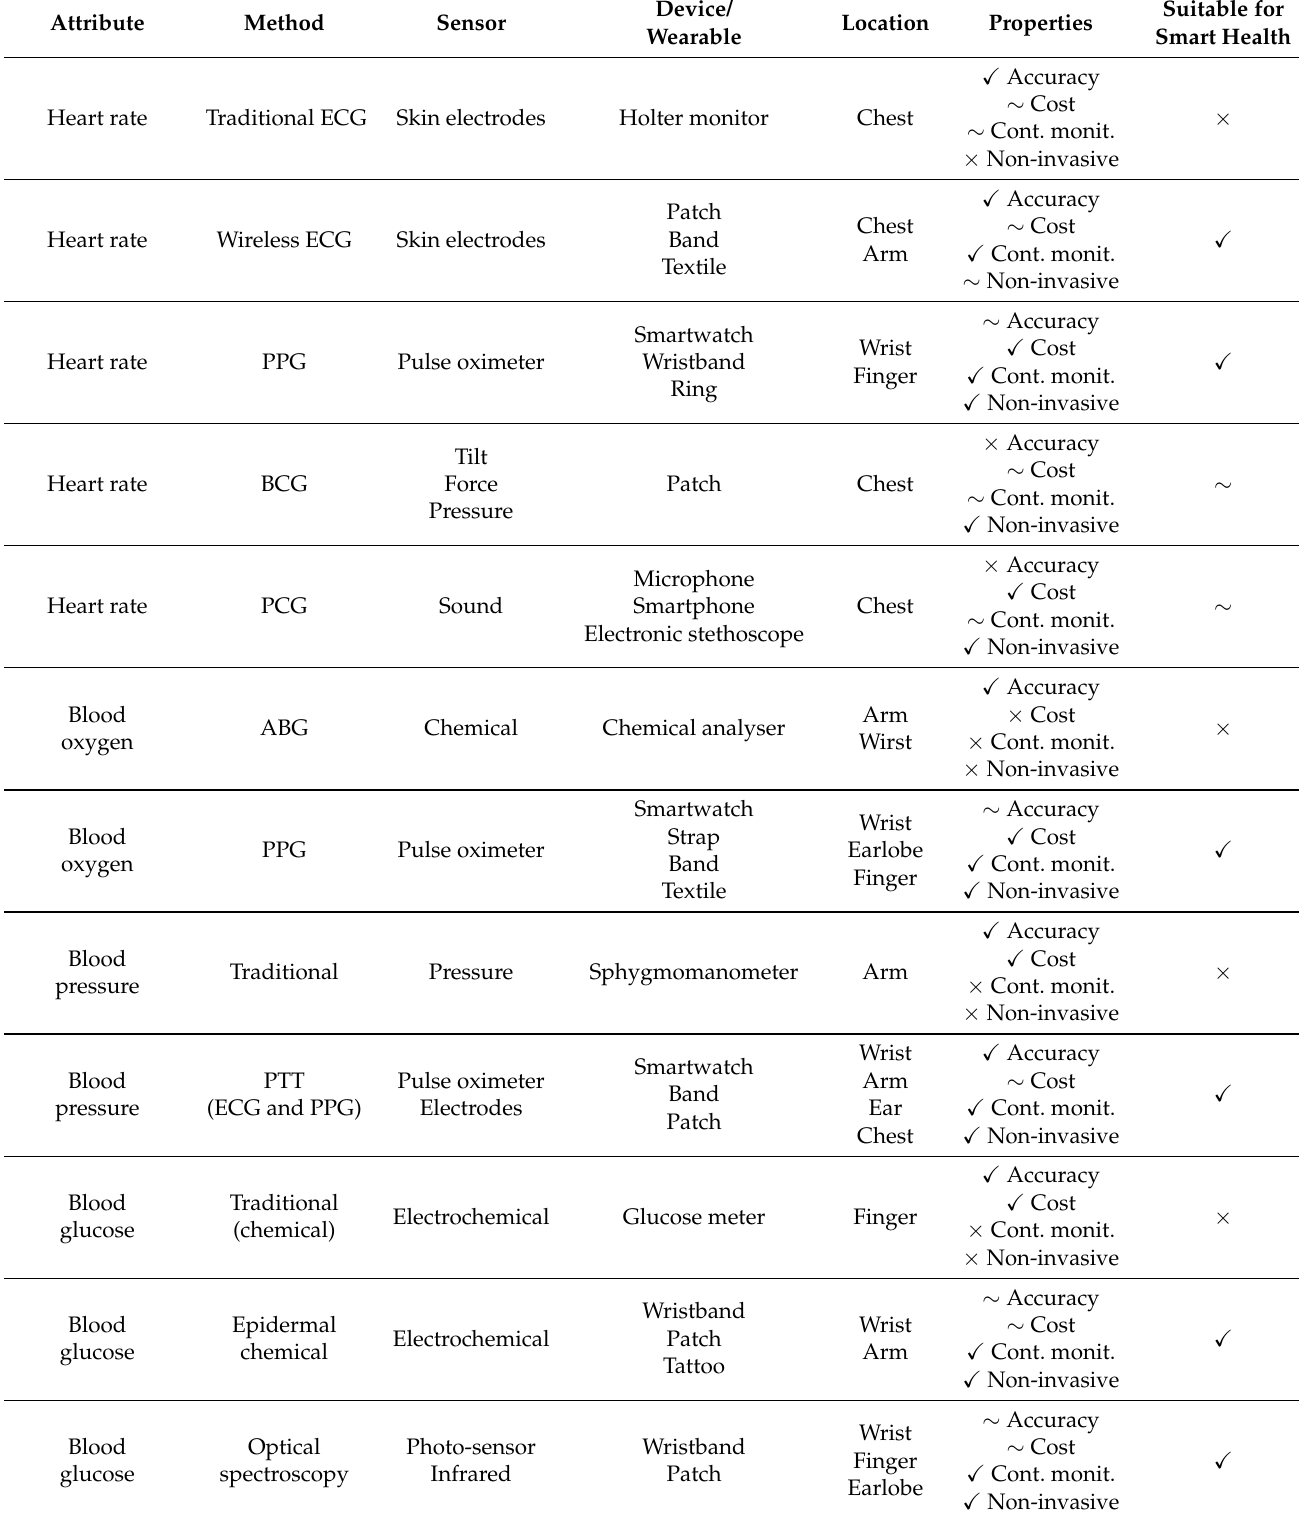
Table 2. Characteristics of the methods for cardiovascular activity